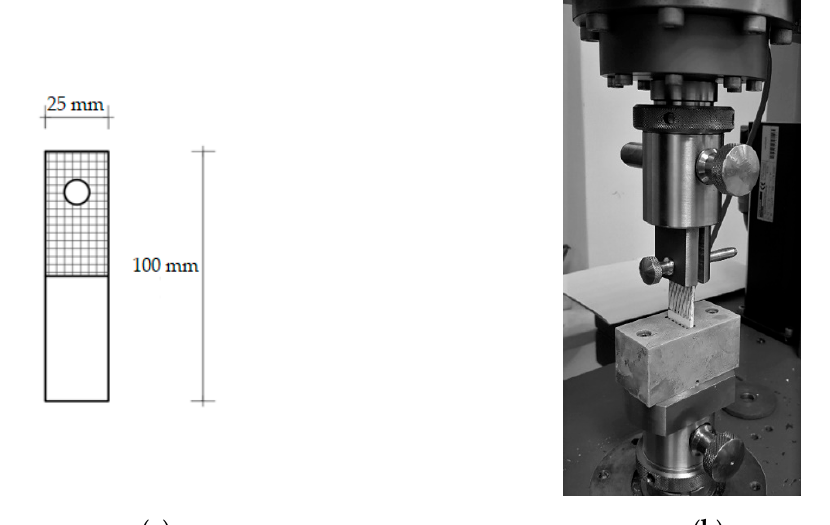
Figure1. ( a )Sketchofthesampleforiceadhesiontestingand( b )testingmachinewithamountedsample. Figure 1. ( a ) Sketch of the sample for ice adhesion testing and ( b ) testing machine with a mounted sample.